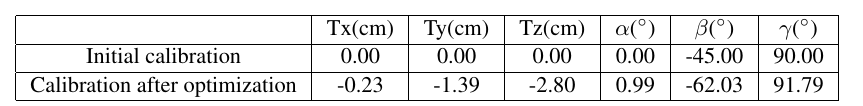
Table 15: Calibration of real point cloud #3